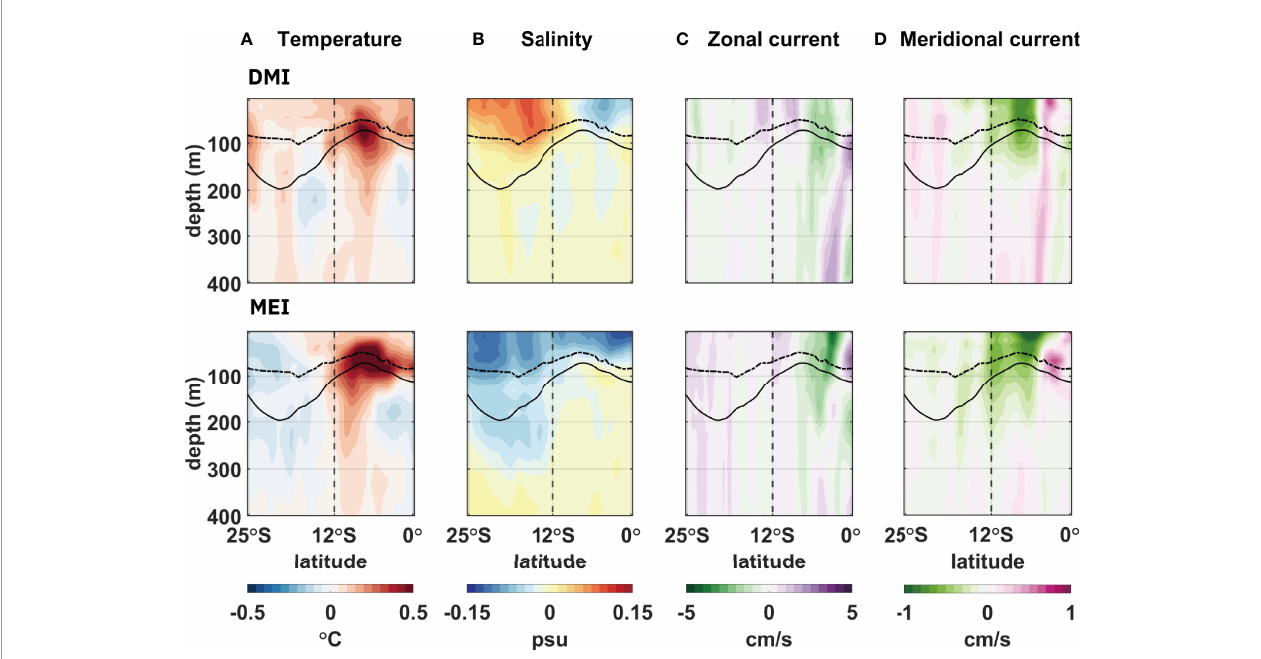
FIGURE 5 | Meridional distribution of the regressed and reconstructed anomalies of the ocean environmental variables with respect to the normalized Indian Ocean dipole mode index (DMI; top) and normalized multivariate El Niño – Southern Oscillation (ENSO) index (MEI; bottom) for 1990 – 2014. The anomalies are presented after zonal averages from 54°E to 60°E. Each column represents a different variable: (A) temperature (shading intervals: 0.05°C), (B) salinity (shading intervals: 0.015 psu), (C) zonal current velocity (shading intervals: 0.5 cm/s), and (D) meridional current velocity (shading intervals: 0.1 cm/s). The thick dashed/dotted lines and solid lines indicate the mean thermocline depth and D20, respectively. The vertical dashed lines denote 12°S, the boundary between the northern and southern regions of the SWTIO.